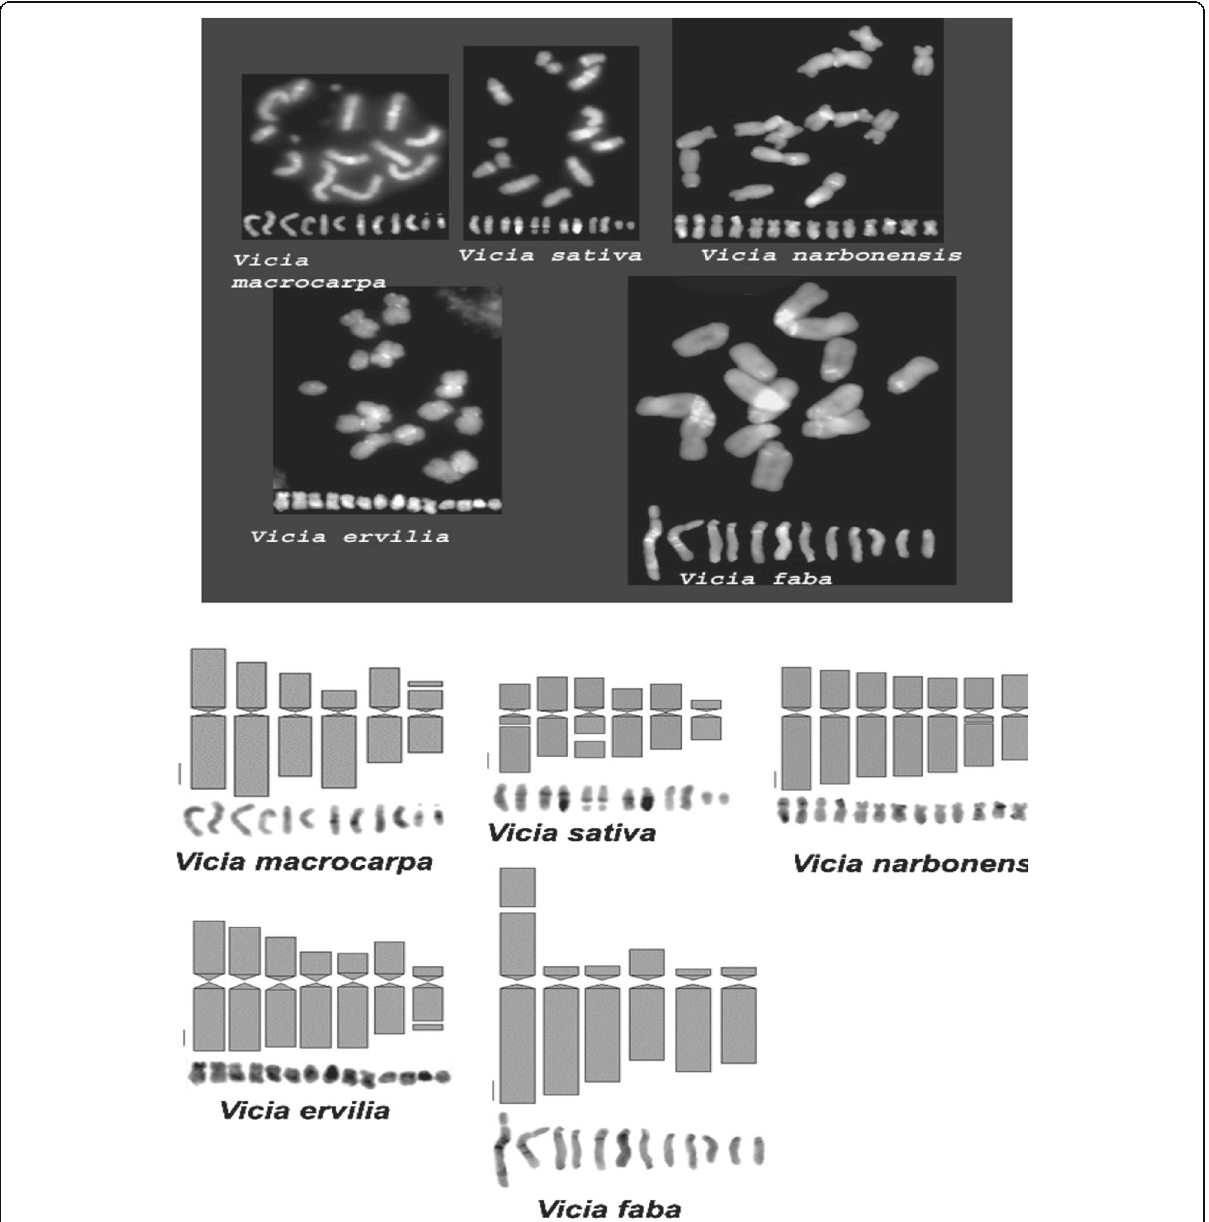
Fig. 1 Karyotype and idiograms of V. macrocarpa , V. sativa , V. narbonensis , V. ervilia , and V. faba (scale = 2 μ